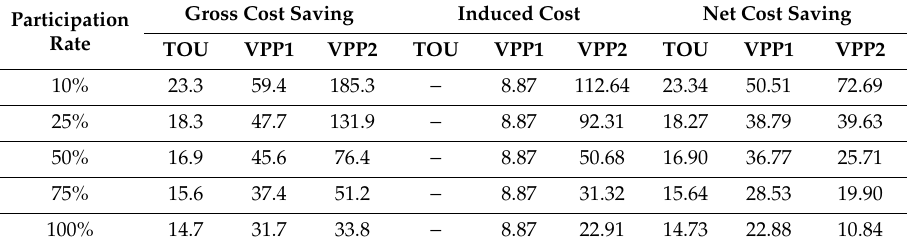
Table 9. Monthly net cost saving per EV by varying participation rates (USD/month).